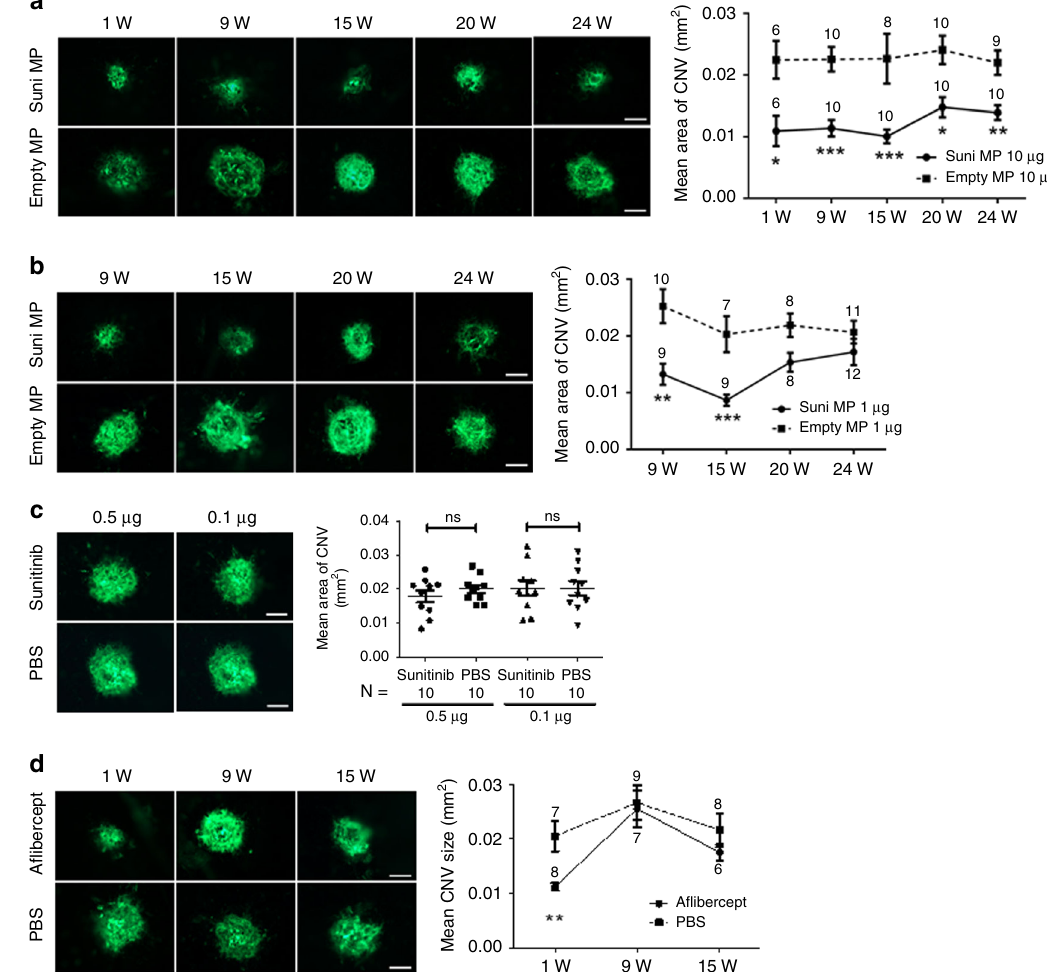
Fig. 2 Effect of sunitinib microparticles in a mouse model of type 2 choroidal neovascularization. C57BL/6 mice received a 1 µ l intravitreous injection of sunitinib (Suni) microparticles (MP) containing 10 or 1 µ g of sunitinib in one eye and an equivalent amount of empty MP in the fellow eye, or they received an injection of 0.5 or 0.1 µ g of free sunitinib in one eye and PBS in the fellow eye, or 40 µ g of a fl ibercept in one eye and PBS in the fellow eye. At various time points after injection ranging from 1 to 24 weeks, the mice had rupture of Bruch ’ s membrane by laser photocoagulation at 3 locations in each eye. One week after laser, mice were euthanized and choroidal fl at mounts were stained with FITC-labeled Griffonia Simplicifolia Agglutinin (GSA) lectin and the area of choroidal neovascularization (CNV) was measured at Bruch ’ s membrane rupture sites by an investigator masked with regard to treatment. The three values from each eye were averaged to give a single experimental value. The mean (±SEM) area of CNV was signi fi cantly less in eyes injected with MP containing 10 µ g sunitinib compared with fellow eyes injected with empty MP at each time point through 24 weeks ( a ). Eyes injected with MP containing 1 µ g sunitinib showed a signi fi cant reduction in mean area of CNV compared with corresponding controls at 9 and 15 weeks, but not 20 and 24 weeks ( b ). Eyes injected with 0.5 or 0.1 µ g of free sunitinib showed no signi fi cant reduction in area of CNV compared to fellow eyes injected with PBS at 1 week ( c ). Eyes injected with 40 µ g of a fl ibercept showed a signi fi cant reduction in mean CNV area compared with fellow eye controls at 1 week, but not 9 or 15 weeks ( d ). Number of animals used in each group are shown in the graph or below the graph. * p < 0.05; ** p < 0.01, *** p < 0.001 by Mann – Whitney compared with fellow eye control at that time point. Bar = 100 µ m. Source data are provided as a Source Data fi